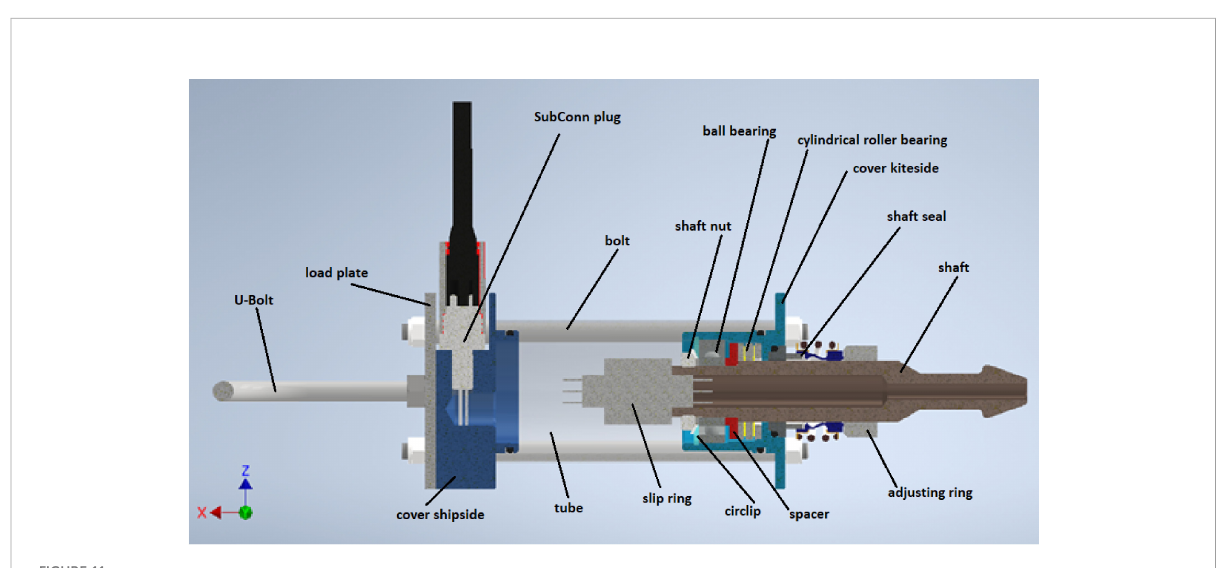
FIGURE 11 Main components of the